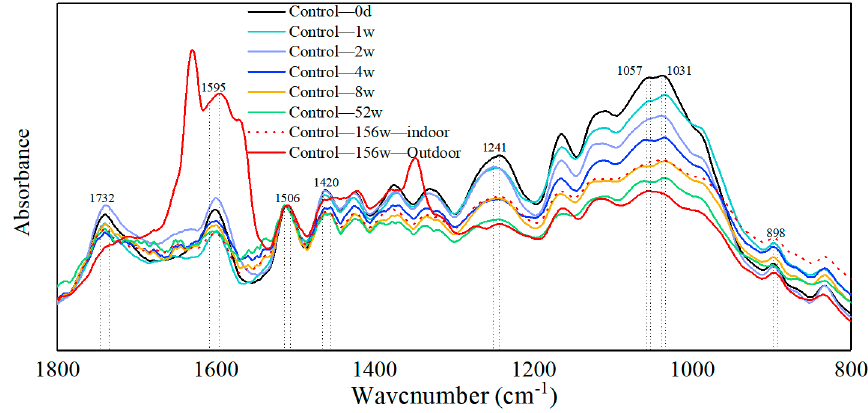
Figure 9. Fourier infrared spectra of bamboo during natural indoor ageing.